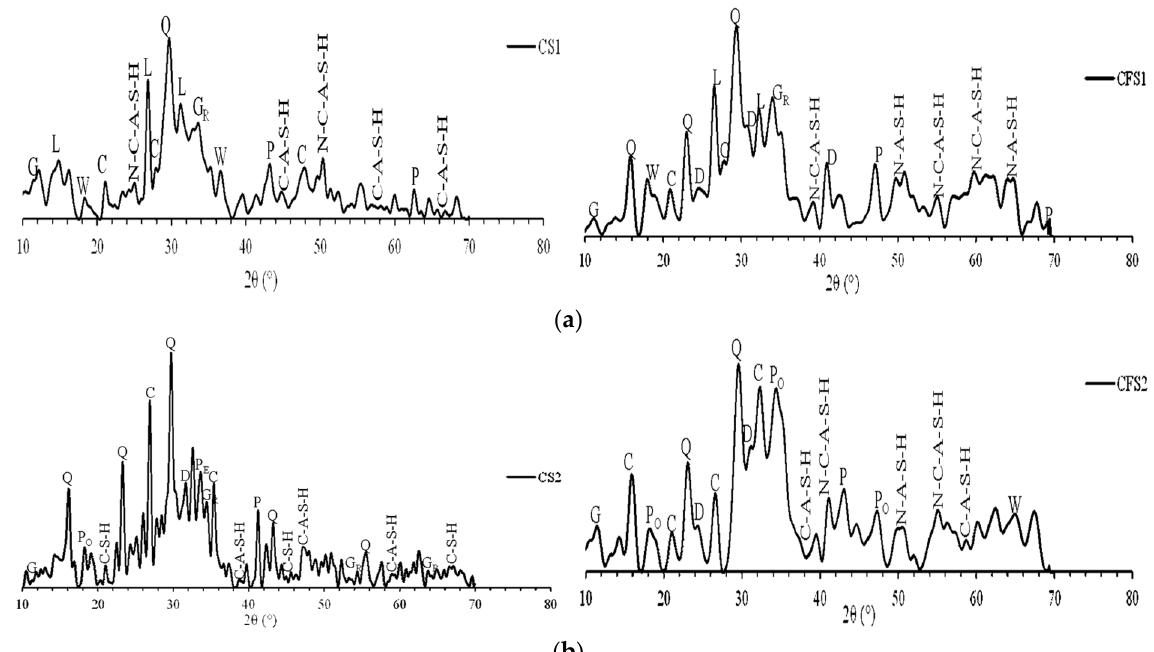
Figure 16. XRD patterns: ( a ) CS1 and CFS1, ( b ) CS2 and CFS2 (Q-quartz, G-gypsum, D-dolomite, G R -grossular, P o -portlandite, P-periclase, L-lalondeite, C-calcite, W-wadalite).